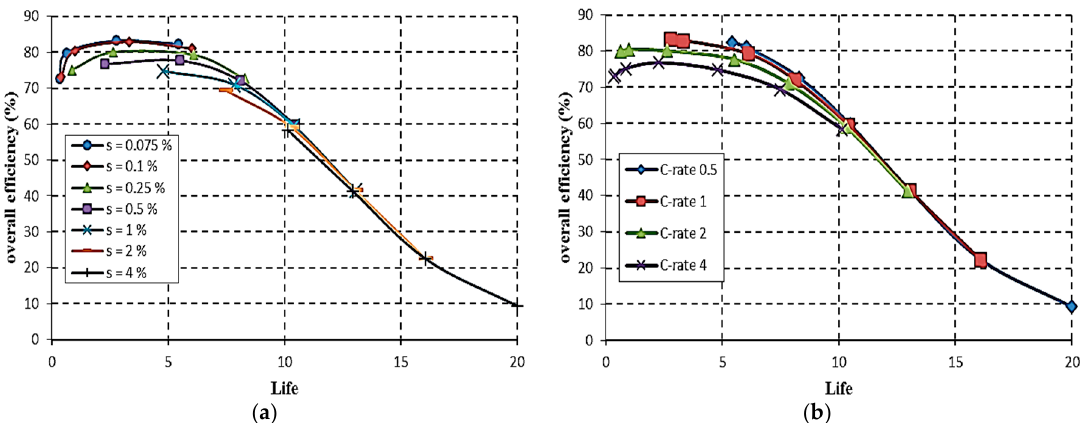
Figure 12. Overall efficiency vs. expected life: ( a ) as a function of droop; ( b ) as a function of C-rate .